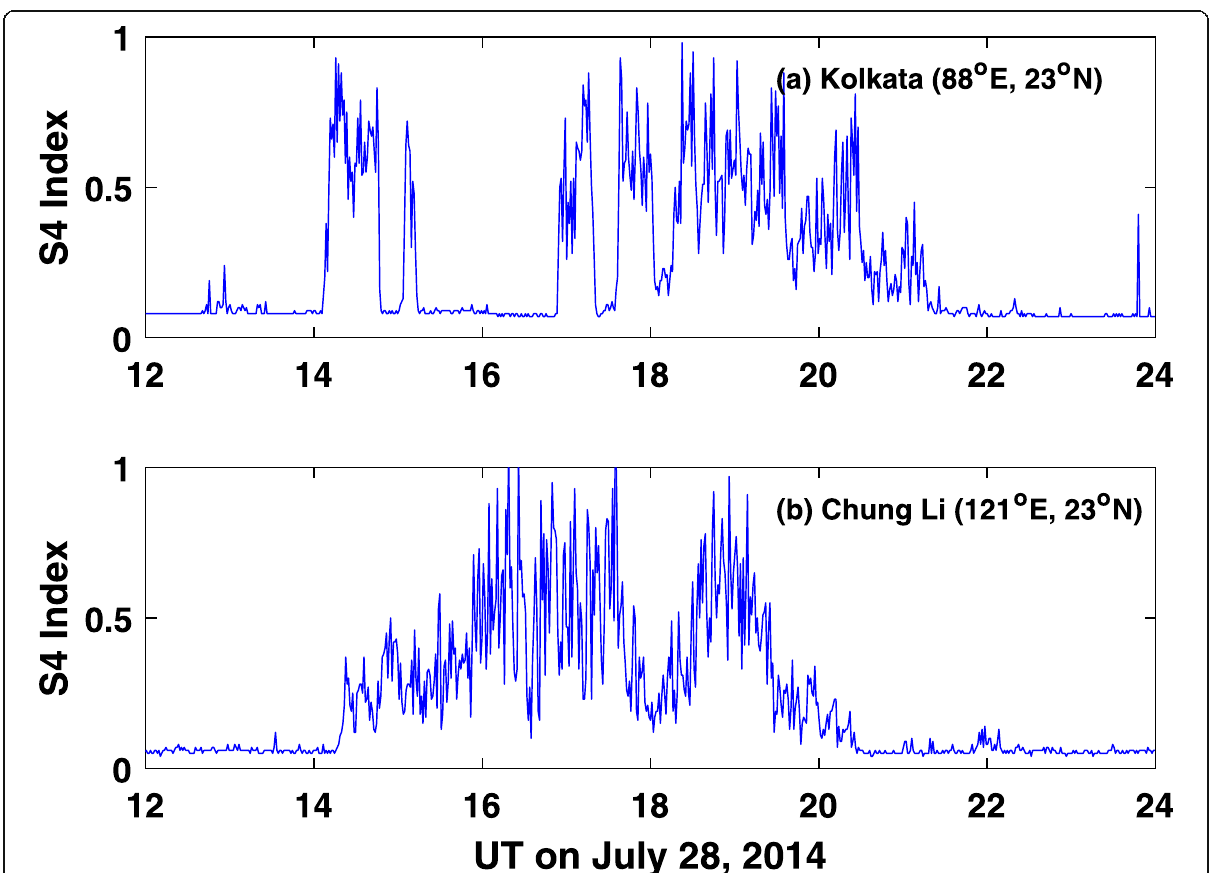
Fig. 3 The S4-index recorded during the night of 28 July 2014 from the ground stations located in a Kolkata and b